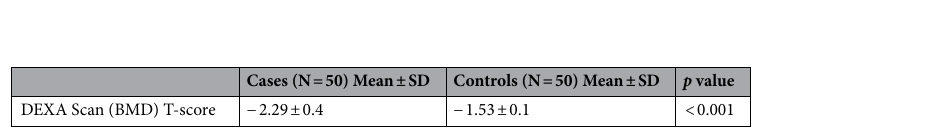
Table 3. Factors affecting bone density among studied groups. PTH parathyroid hormone, Ca calcium, P phosphorus.